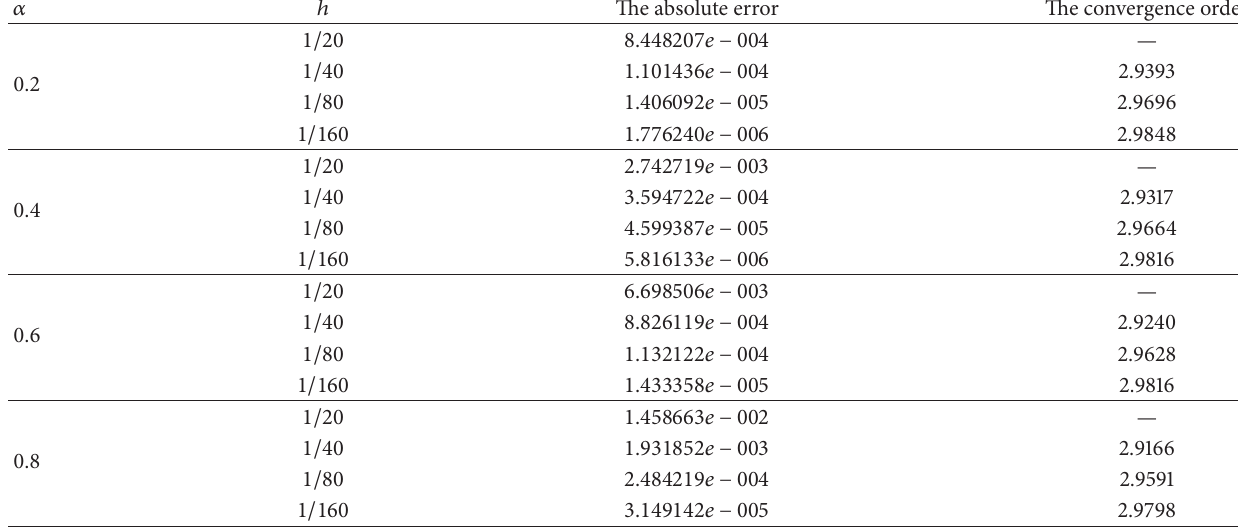
Table 5: The numerical results of the Example 9 by formula (14) with 𝑝 = 3 .